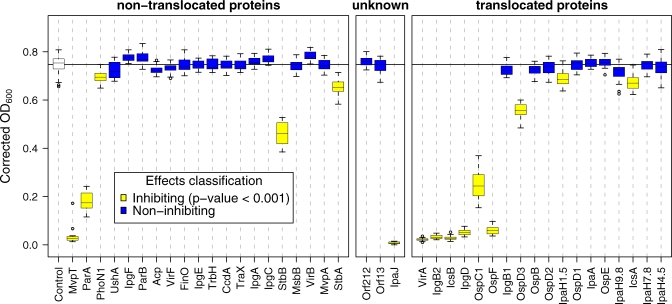
Growth Phenotypes Conferred by Expression of Shigella Proteins in YeastEach box-and-whisker plot summarizes the OD600 measurements of 22 independent yeast cultures expressing a single Shigella protein at t = 48 h. Proteins shown in yellow represent those whose expression resulted in a significant reduction in growth when compared to the control (p < 0.001 in a Wilcoxon two-sample test with Bonferroni correction). “Control” refers to yeast that carry empty vector. The boxes enclose approximately one quartile either side of the median. The whiskers delimit the ∼95% confidence interval for the mean (using default rendering parameters in the statistical computing software package R [55]).